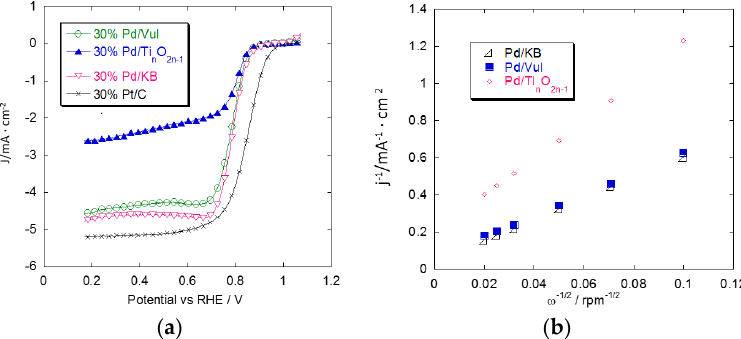
Figure 4. ( a ) Comparison of oxygen reduction voltammetric curves for the different Pd/support catalysts and the commercial Pt/C E-TEK catalyst. Scan rate 5 mV·s − 1 ; 1000 rpm; room temperature and 50 μ g·cm − 2 of Pd or Pt loading; ( b ) Koutecky-Levich plots for 30% Pd/Vul, 30% Pd/KB, 30% Pd/Ti n O 2 n ´ 1 obtained from the RDE data at 0.7 V vs. RHE.